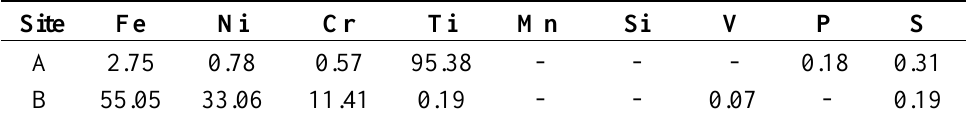
Figure 4. Transmission electron microscope analysis (TEM) analysis of A-286 tested at 1220 °C, ( a ) cross sectional view, and ( b ) diffraction pattern of the surface layer (A region), ( c ) diffraction pattern of the matrix (B region). Table 3. TEM-EDS results in wt.